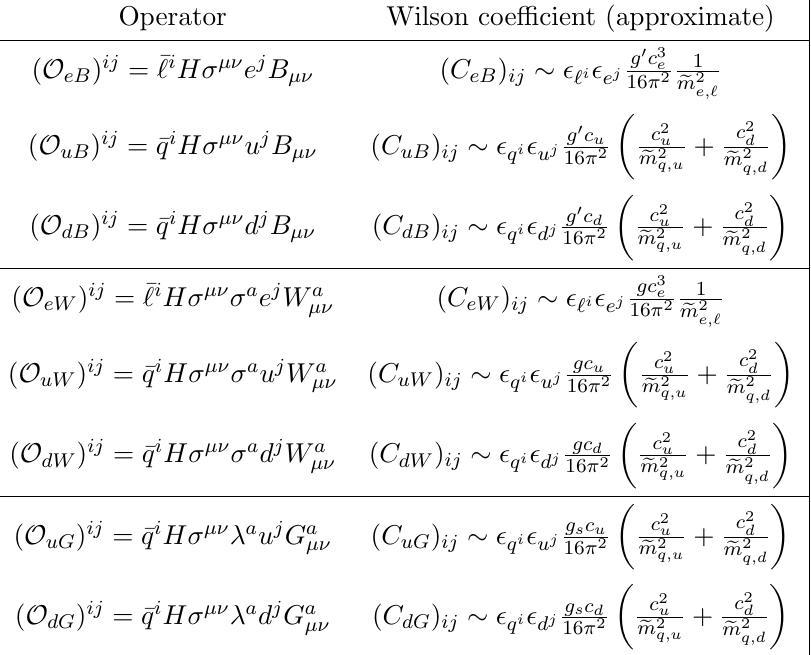
Table 6. Dipole operators and their Wilson coe(cid:14)cients. Here the scale two scales m a , m b e e